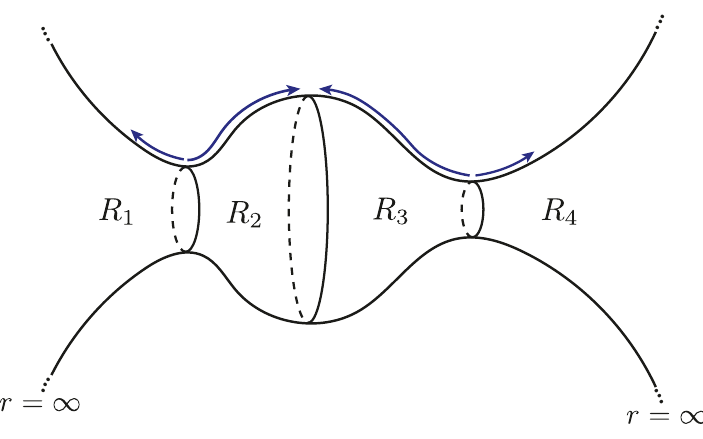
Figure 5 . Example of a two-dimensional spherically symmetric hypersurface Σ with three station- ary surfaces. This manifold can be covered by four coordinate systems of the form (2.21), and ω ( r ) increases along the blue